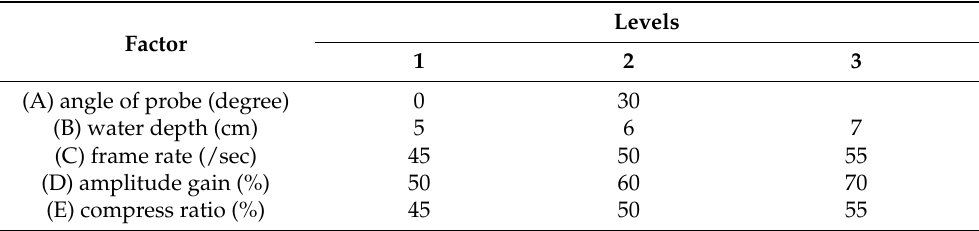
Table 2. Five factors (each bearing two or three levels) used in the proposed sonography protocol, according to Taguchi’s settings in Table